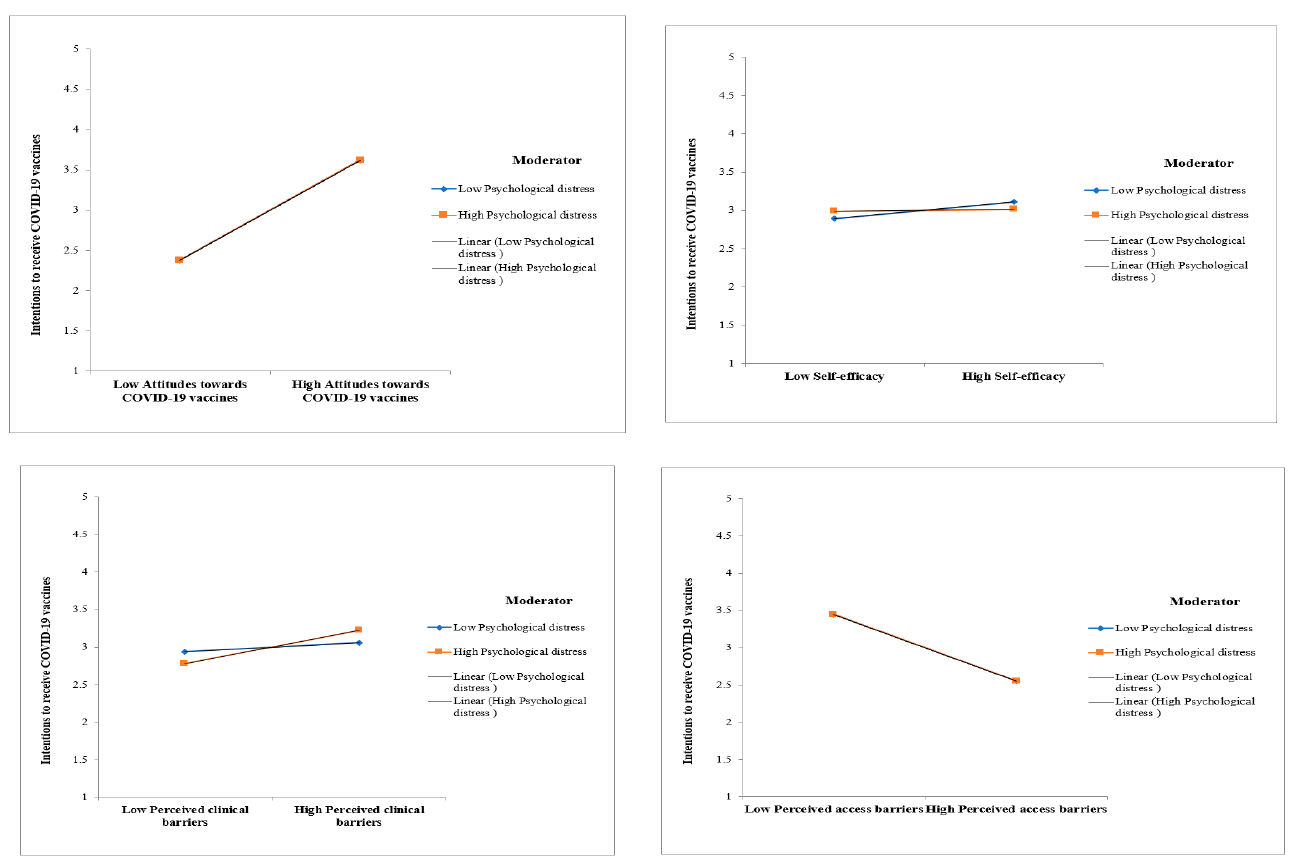
Figure 4. Interaction plots.